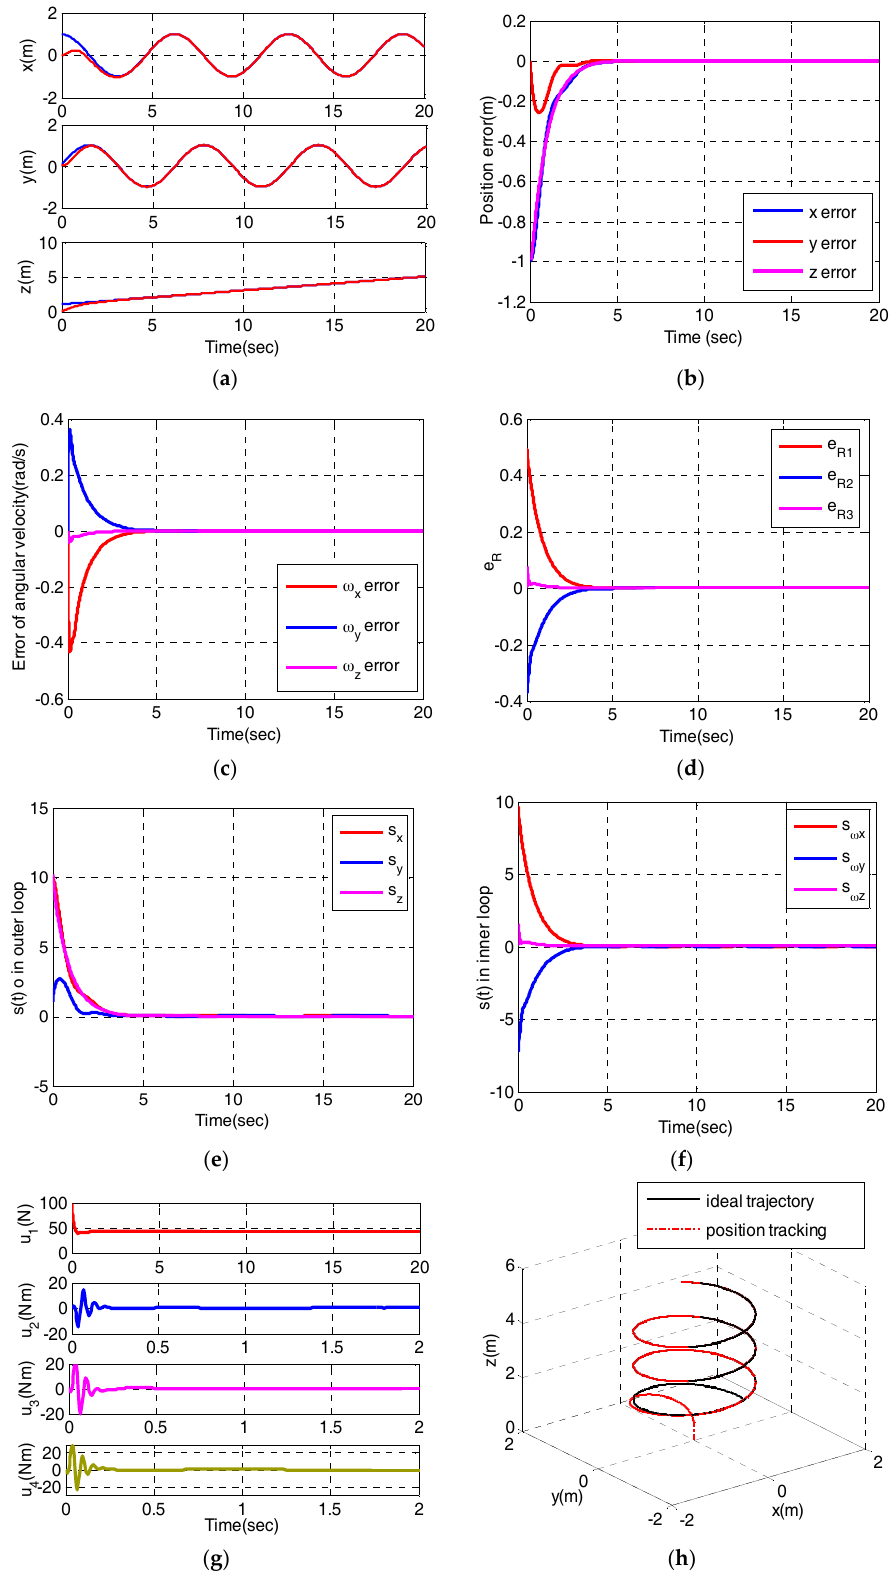
Figure 4. Tracking helical trajectory simulation ( a ) Position; ( b ) Error of position; ( c ) Error of angular velocity; ( d )Vector form of attitude error; ( e ) The sliding variables in outer loop; ( f ) The sliding